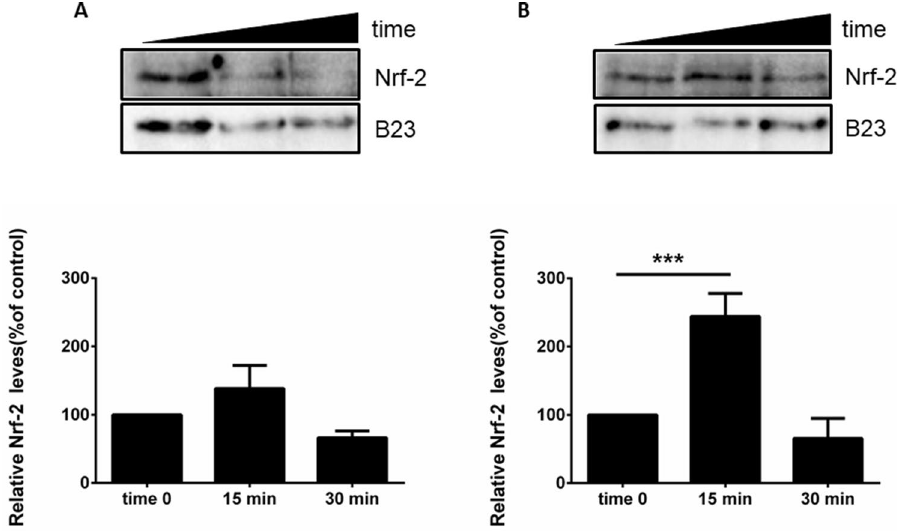
Figure 3. Effect of T. algeriensis (TA) and T. fontanesii (TF) extracts on the Nrf-2 levels of the HaCaT cells. After incubation of the HaCaT cells for 15 min (white bars) or 30 min (dark grey bars) with 50 µg/mL of either TA ( A ) or TB ( B ) extracts, nuclear proteins were extracted and used for Western blot analyses. The protein intensity levels were normalized to the internal standard (B-23) after being estimated by densitometric analysis. Statistical analysis was performed using one way-ANOVA, followed by Turkey’s post hoc test. ***Corresponds to p < 0.005 compared to control cells.